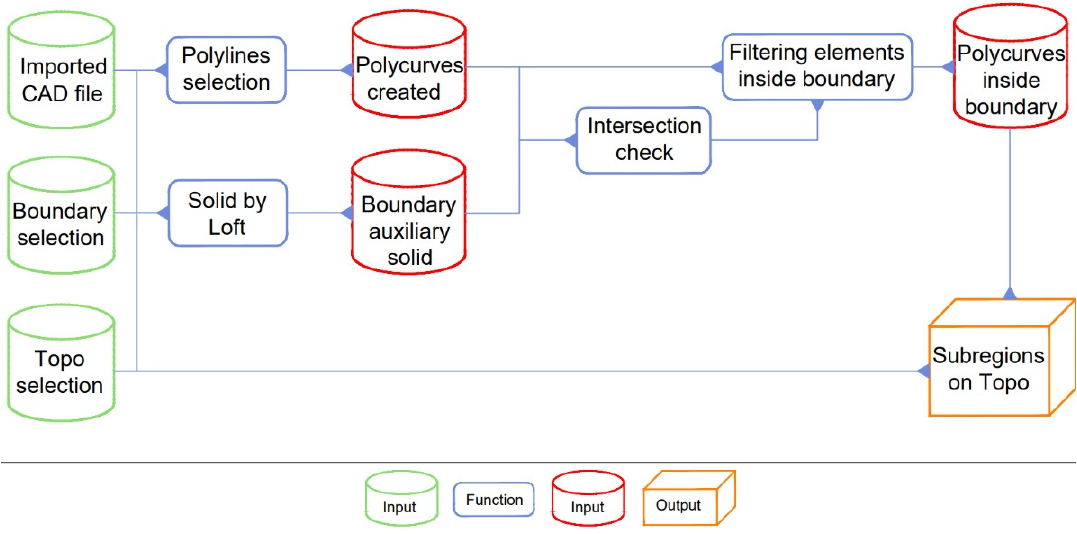
Figure 4. Pipeline for the VPL routine.